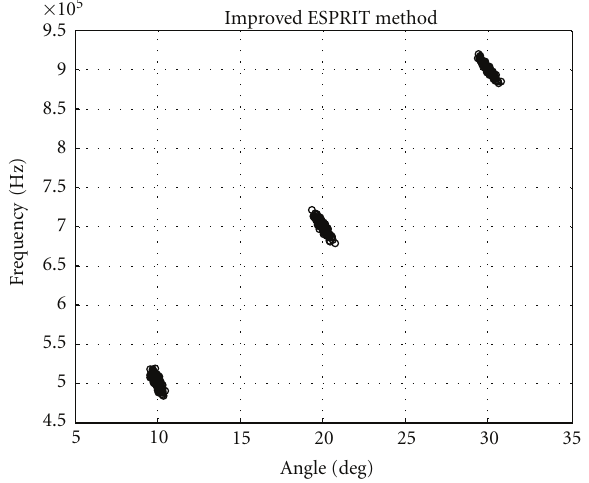
Figure 2: Angle-frequency scatter of proposed method, SNR = 0dB.